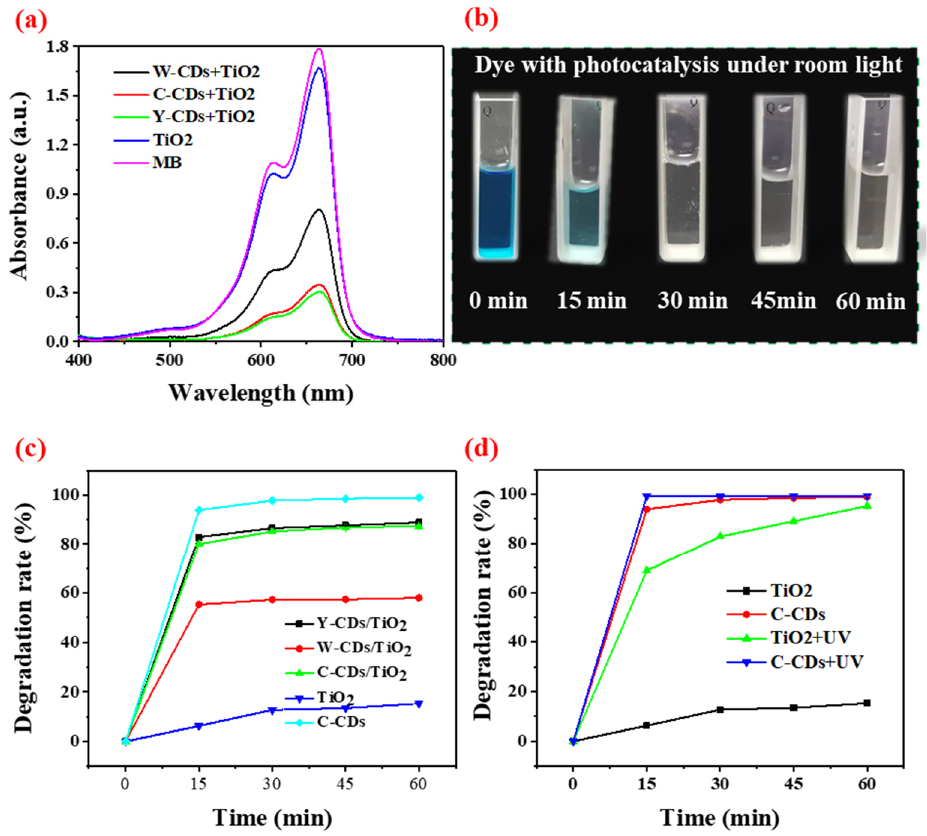
Figure 7. Absorption spectra of the MB solution with a 15 mg·L − 1 concentration treated by the TiO 2 and TiO 2 /CDs composites for 15 min under visible light ( a ); representative images of MB degradation by the C-CDs, collected at different times under visible light ( b ); degradation efficiency of MB with different catalysts under room light ( c ), and photocatalytic degradation rate of MB by TiO 2 and the C-CDs under visible and UV light ( d ).